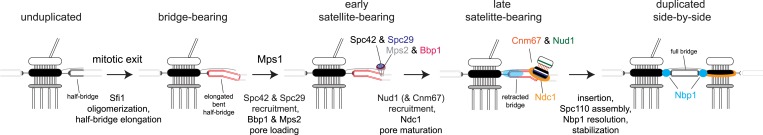
Model for SPB duplication.Revised model of the early steps in SPB duplication based on results described. In anaphase, Sfi1 oligomerization leads to an elongated half-bridge. Next, Spc42 and Spc29 assemble at the distal cytoplasmic tip of the bridge. At the same time, the pore proteins Bbp1 (magenta) and Mps2 (gray) accumulate at the satellite region. Later, the satellite and membrane-associated region continue to mature through the addition of Nud1 (green), Cnm67 (orange), and Ndc1 (orange ring). Nbp1 (cyan) remains associated primarily with the mother-proximal end of the extended half-bridge until the SPB is inserted into the NE. Note that satellite and pore-associated proteins are also present at the mother SPB.